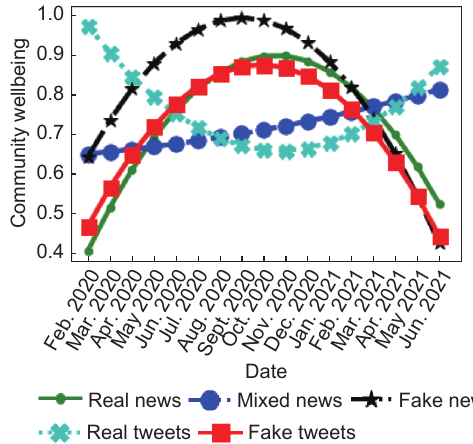
Fig. 6 Community wellbeing measured by different types of news (i.e., real, mixed, and fake) and tweets (i.e., real and fake).